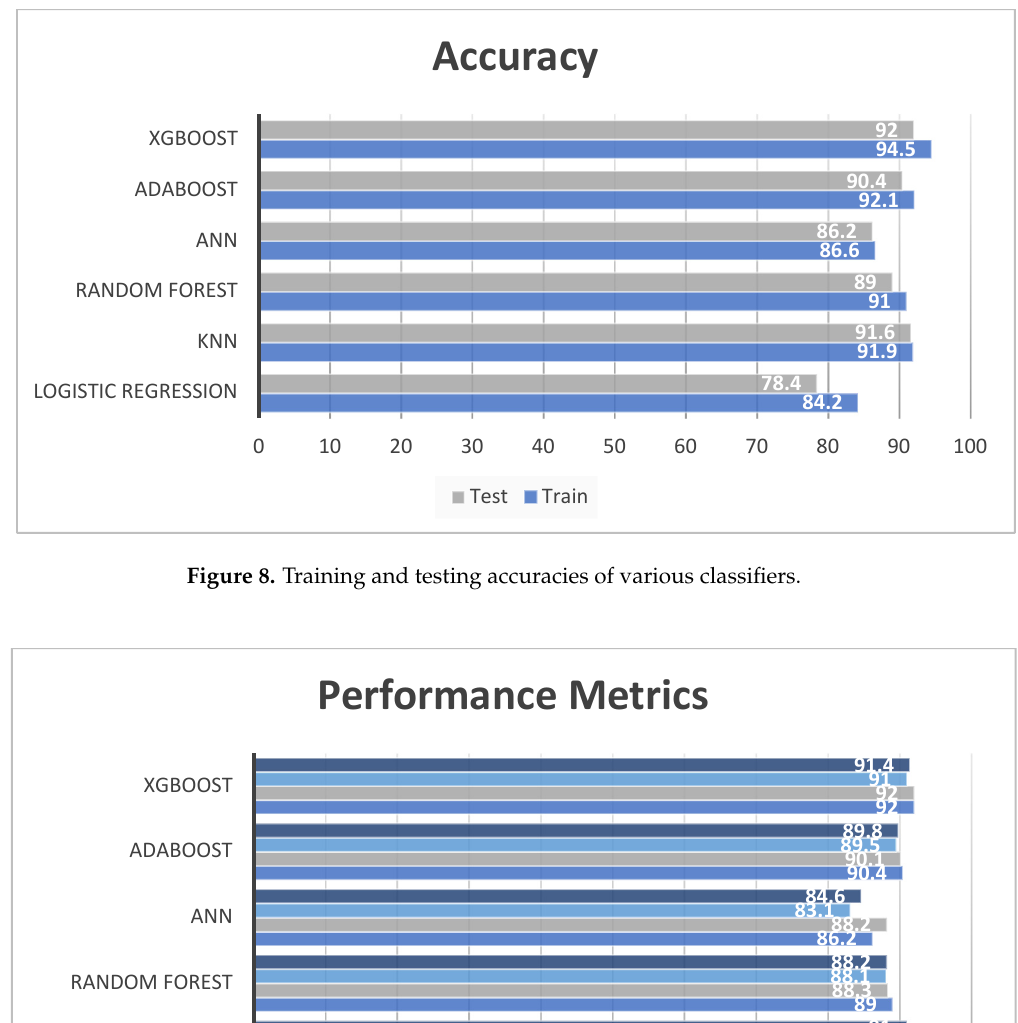
Figure 7. AUCs of various classifiers that diagnose COVID-19.